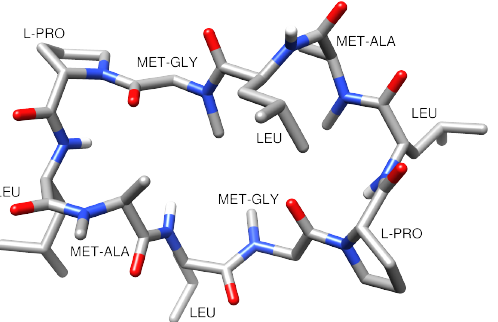
Figure 3. Sequence and structure of the cyclic decapeptide CDP5 with four N-methylated